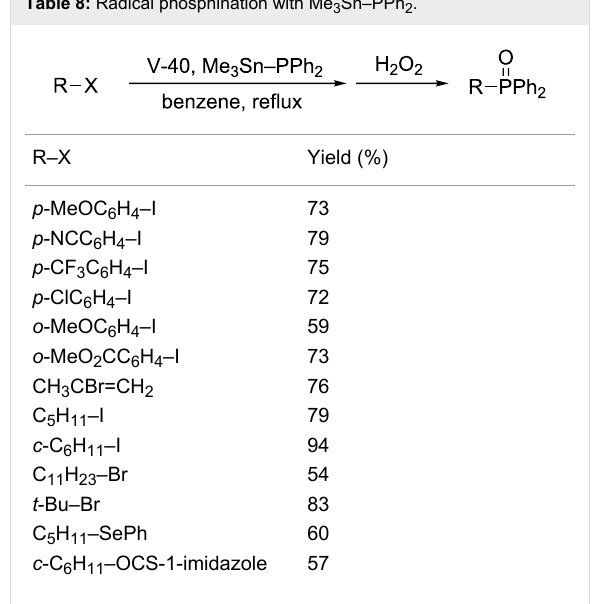
R 1 R 2 Yield (%) c -C 6 H 11